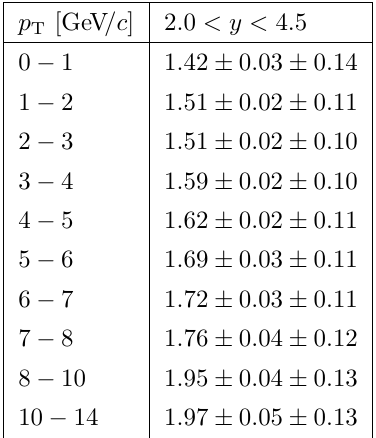
Table 14 . Cross-section ratios between 8 TeV and 5 TeV measurements for nonprompt J/ψ mesons as a function of p T with 2 . 0 < y < 4 . 5 . The first uncertainty is statistical and the second is